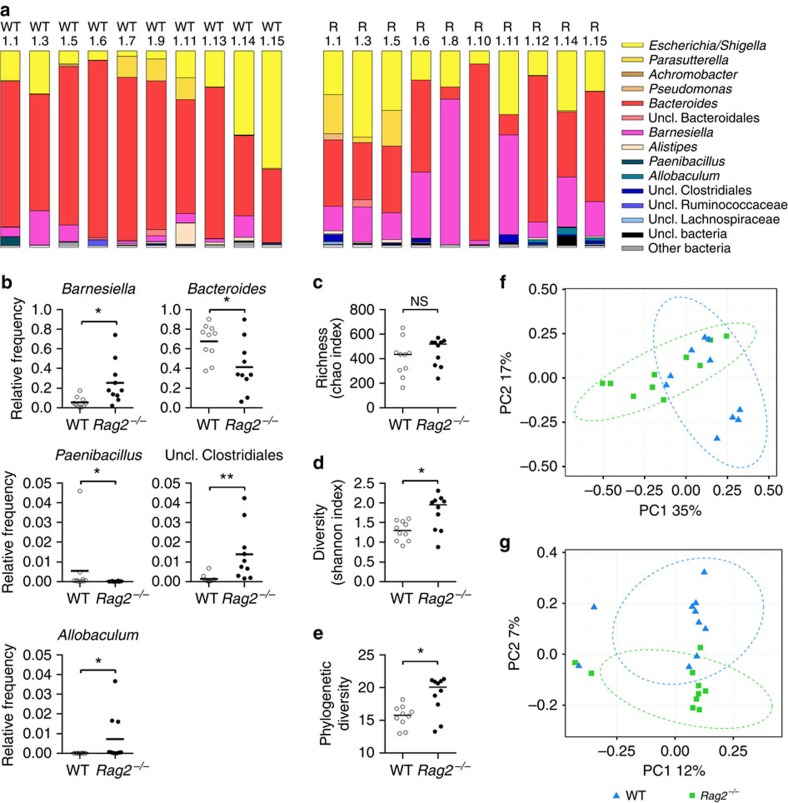
Microbiota composition differs between immune-competent and immune-compromised hosts.(a) Microbiota composition at the genus level of 10 WT and 10 Rag2−/− mice from the day 3 of the evolution experiment (streptomycin-treated and colonized with E. coli). Genera with a relative abundance larger than 1% are displayed. The coloured segments represent the relative frequency of each genus. (b) Relative frequencies of genera differentially represented in WT and Rag2−/− animals: Barnesiella (Mann–Whitney U-test with the Benjamini and Hochberg correction, W=11, P=0.021), Bacteroides (Mann–Whitney U-test with the Benjamini and Hochberg correction, W=18, P=0.049), Paenibacillus (Mann–Whitney U-test with the Benjamini and Hochberg correction, W=14.5, P=0.029), unclassified Clostridiales (Mann–Whitney U-test with the Benjamini and Hochberg correction, W=6, P=0.0065) and Allobaculum (Mann–Whitney U-test with the Benjamini and Hochberg correction, W=13, P=0.025). *P<0.05, **P<0.01. Alpha diversity estimates of microbiota community richness (c), diversity (d) and phylogenetic diversity (e) in WT and Rag2−/− animals. Both OTU-based diversity and phylogenetic diversity are increased in Rag2−/− animals compared with WT (Mann–Whitney U-test, W=20, P=0.03 and W=17, P=0.01, respectively). NS, not significant; P>0.05, *P<0.05. Principal coordinate analysis (PCoA) of the Bray–Curtis (f) and weighted UniFrac (g) distance matrices of faecal microbiota of WT and Rag2−/− mice. The first two coordinates are shown. Ellipses centred on the averages of the metric distances with a 90% confidence interval for the first two coordinates were drawn on the associated PCoA.